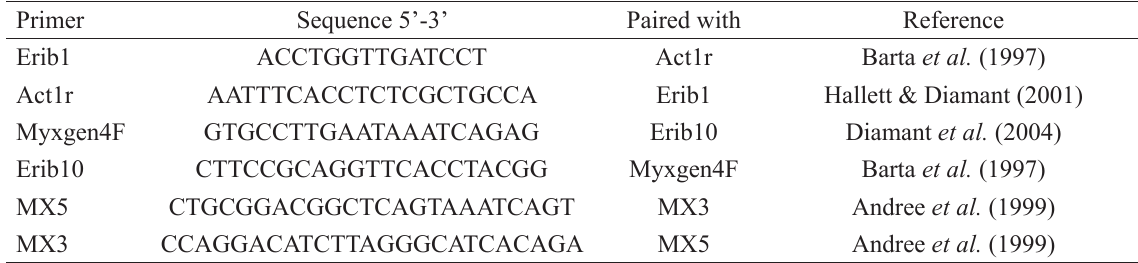
Table 1. Primers used for the amplification and sequencing of the SSU rDNA of Cystodiscus elachistocleis sp. nov. found parasitizing the gallbladder of Elachistocleis cesarii (Miranda-Ribeiro, 1920) from Araguaiana, Mato Grosso State,